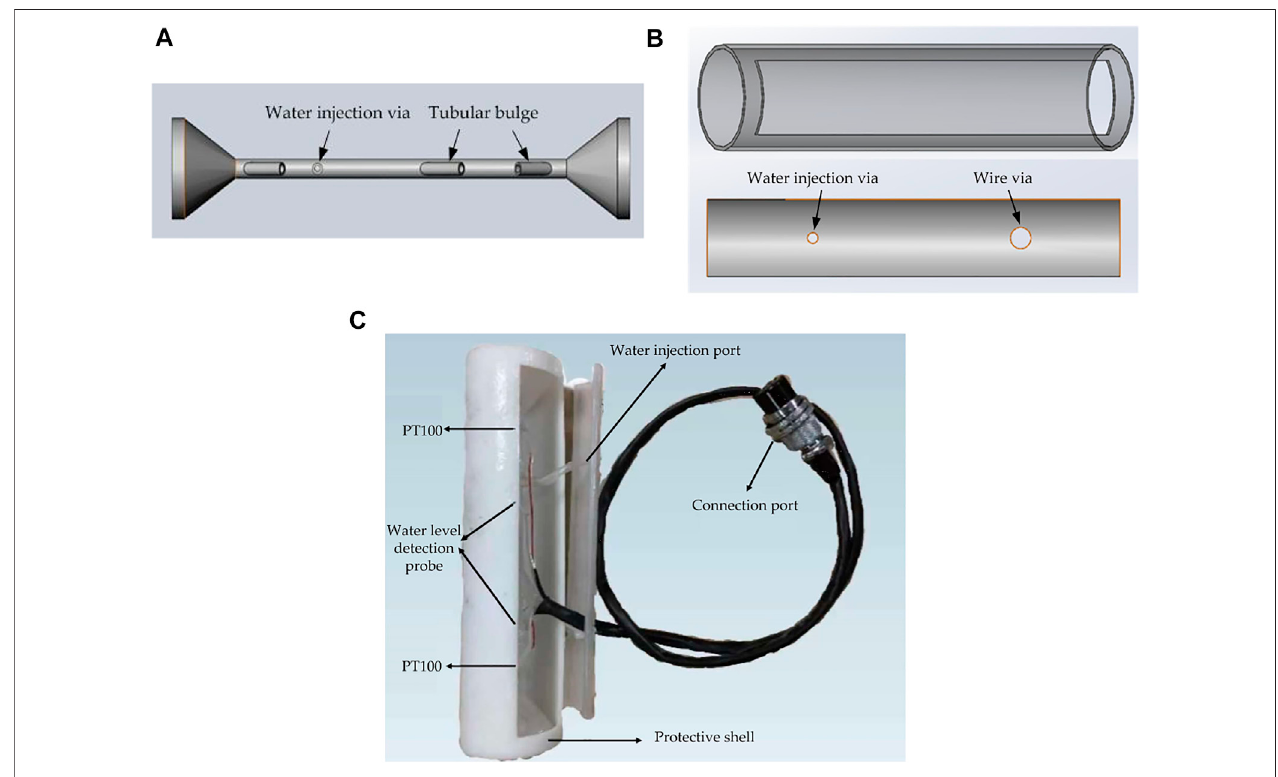
FIGURE2| Seepagesensor (A) thestructureofthesensor; (B) Seepagemeterprotectiveshellandpackagingcover; (C) Physicalimageofseepagemetersensor.